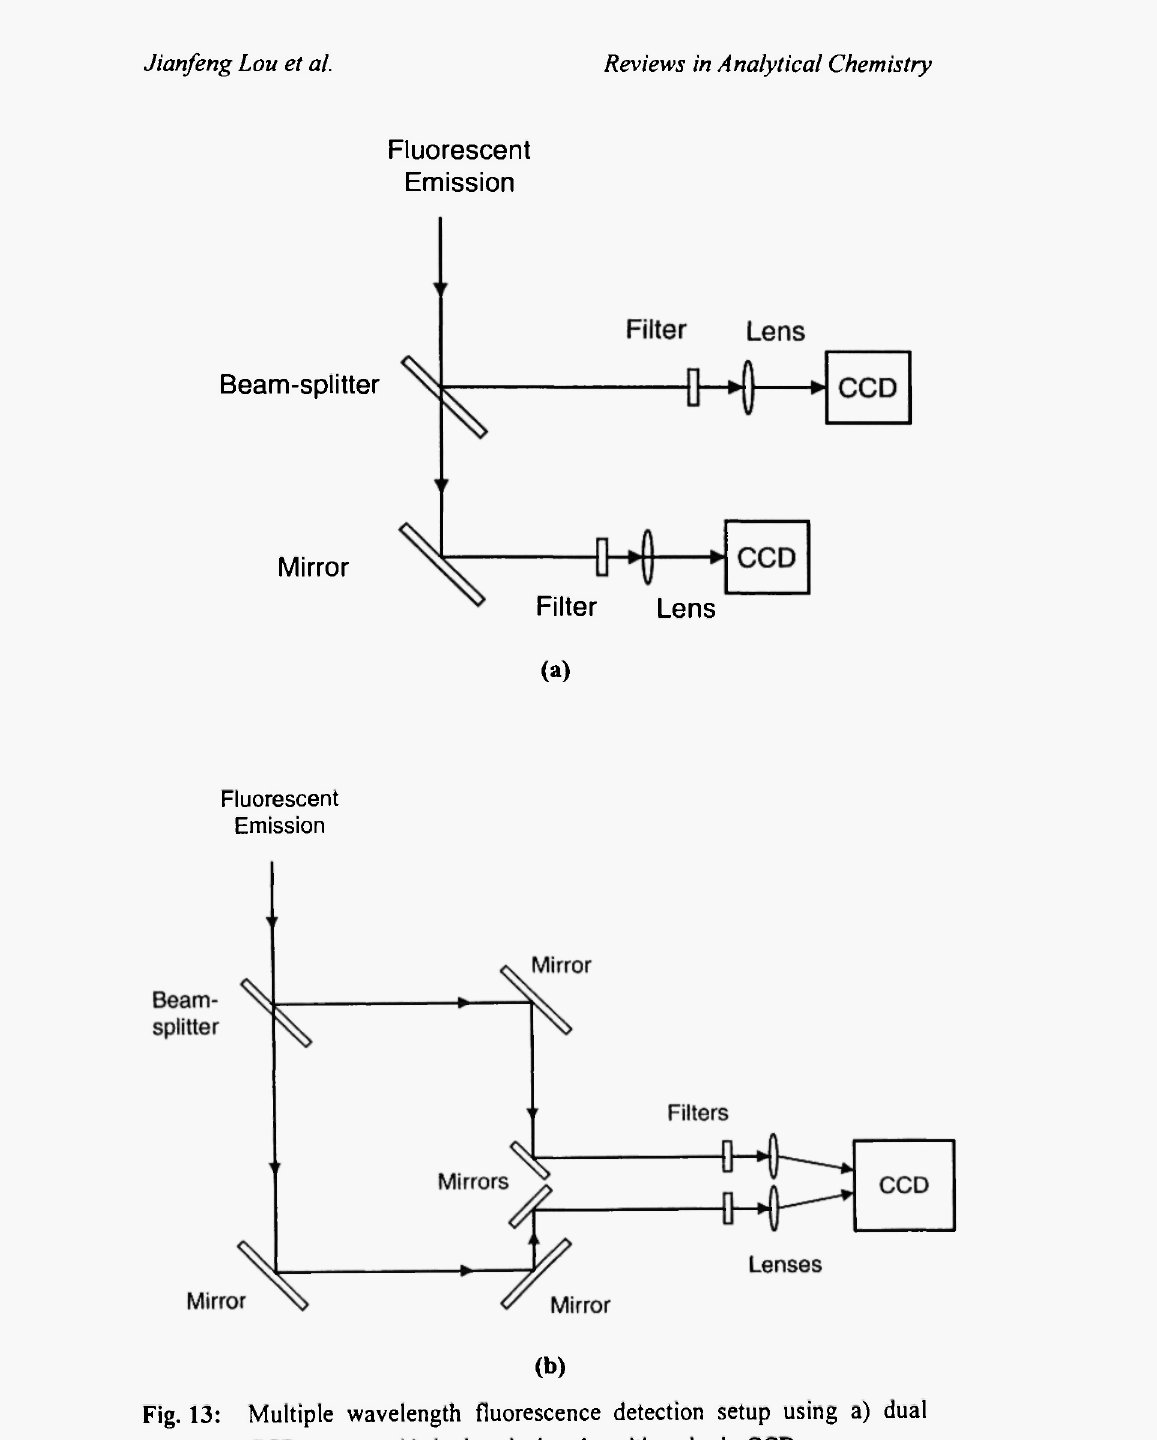
Fig. 13: Multiple wavelength fluorescence detection setup using a) dual CCD cameras, b) dual optical paths with a single CCD camera,